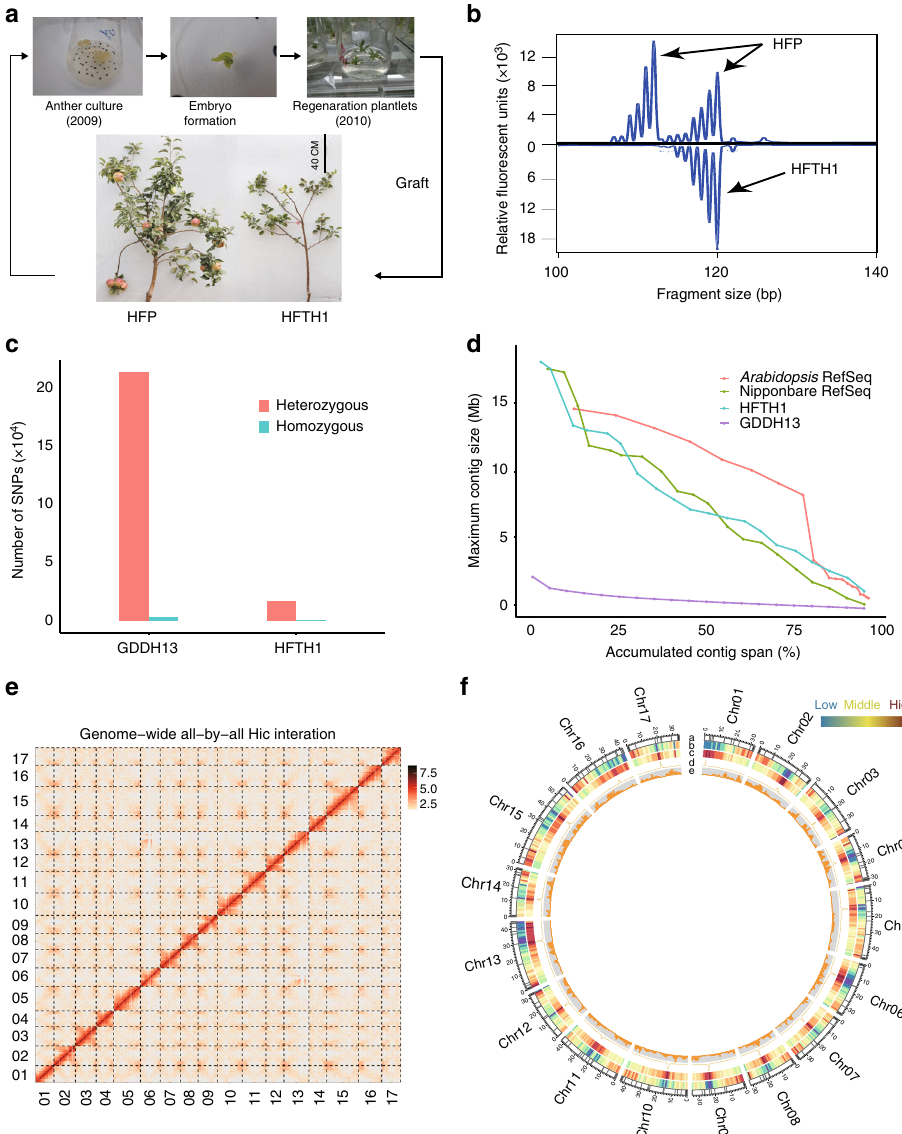
Fig. 1 Overview of the assembly quality and characteristics of the HFTH1 genome. a Regenerated plantlets derived from Hanfu anther culture and the dramatic changes between the HFTH1 phenotype and the heterozygous donor (HFP) genotype. b Homozygosity analysis of chromosome 01 of HFTH1 and HFP using simple sequence repeats (SSRs, the results of the analysis of all chromosomes are shown in Supplementary Fig. 1). c Counts of SNPs detected in the GDDH13 and HFTH1 genomes. SNPs were detected using Illumina reads from the same individual that was used for the assembly. The heterozygous SNP (red) represents the heterozygosity of a genome and the homozygous SNP (blue) represents the potential error for an assembly. d Distribution of the contig length in the assemblies of Arabidopsis (TAIR10), Nipponbare (RGAP7), HFTH1 and GDDH13. Each contig size ( y -axis) represents the minimum contig size that covered the cumulative percentage of the assembly ( x -axis) after the assembled contigs were sorted from the largest to the smallest. e Hi – C interactions among 17 chromosomes with a 100-kb resolution. Strong interactions are indicated in dark red and weak interactions are indicated in yellow. f Circular diagram depicting the characteristics of the HFTH1 genome. The tracks from outer to inner circles indicate the following: a chromosomes (Chr.), gaps and telomeres, the black regions at the end of each chromosome represent assembled the telomere sequences and the grey regions represent gap regions; b gene density (window size of 1 Mb); c repeat density (window size of 1 Mb); d Copia-7; e Golden Delicious shared SNPs (window size